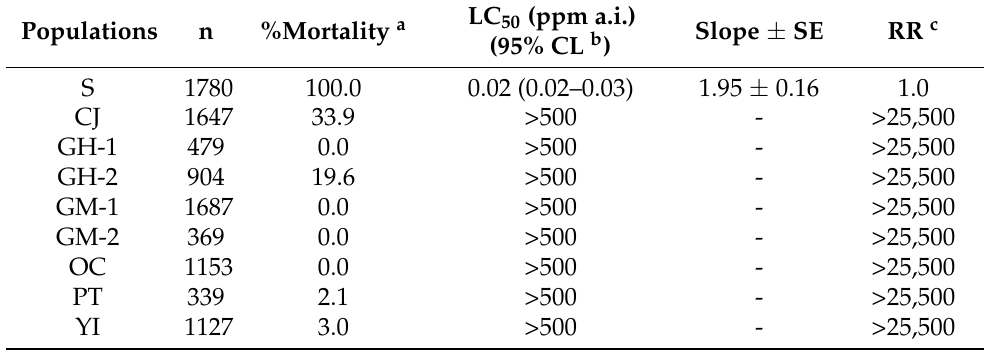
Table 8. Toxicity to etoxazole in susceptible and field-collected populations of T. urticae eggs.